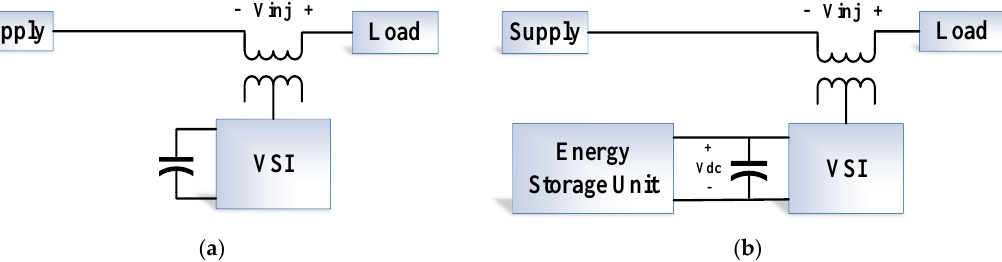
Figure 5. DVR topologies with no energy storage in ( a ) supply-side, ( b ) load-side. Based on data from [7,54].